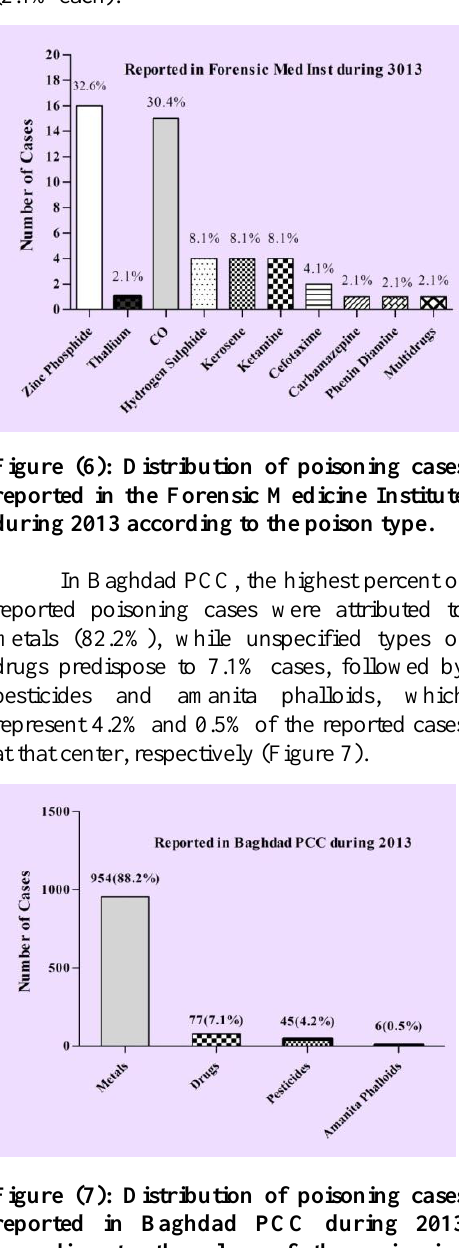
specific type of